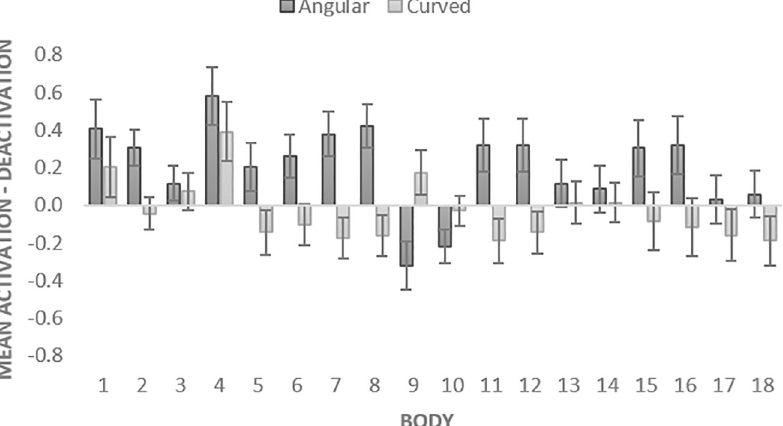
Fig 6. Activation-deactivation in bodily sensations evoked by angular vs. curved pills in Study 2. The bars represent SE.